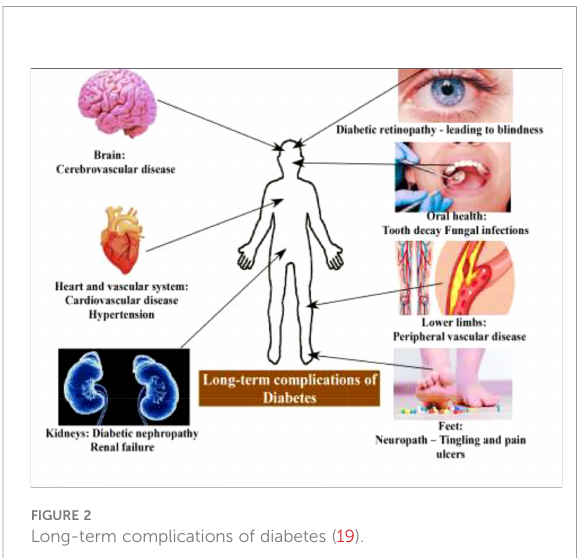
FIGURE 2 Long-term complications of diabetes